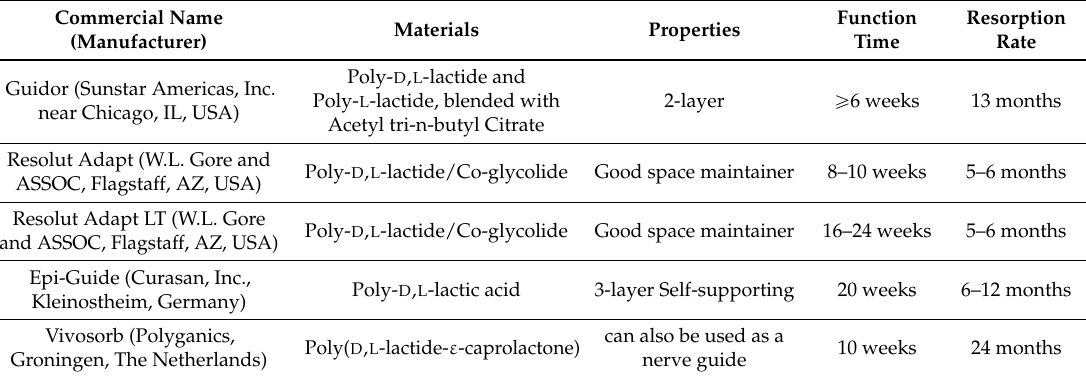
Table 3. The most commonly used commercially available resorbable synthetic polymeric